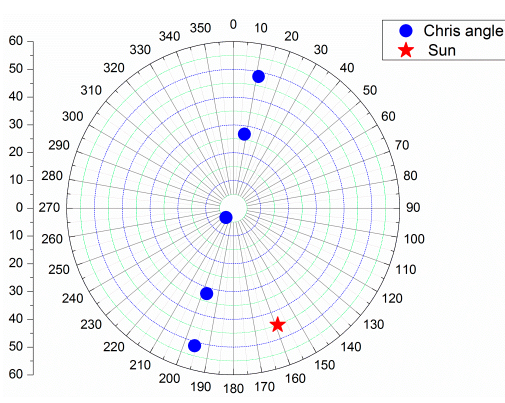
Figure 2. Polar plot of the CHRIS image-viewing geometry.